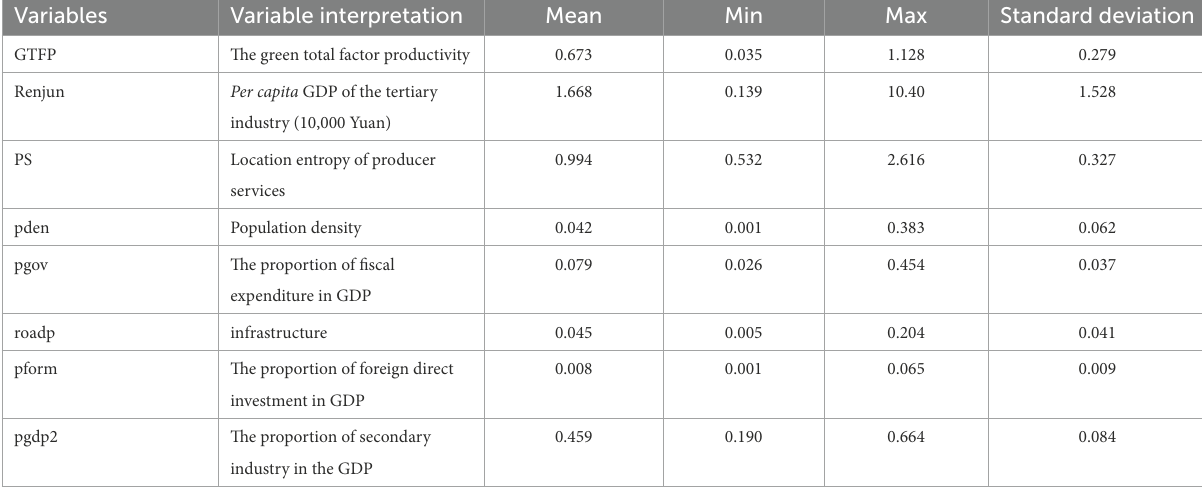
TABLE 1 Variable definition description and statistical description.